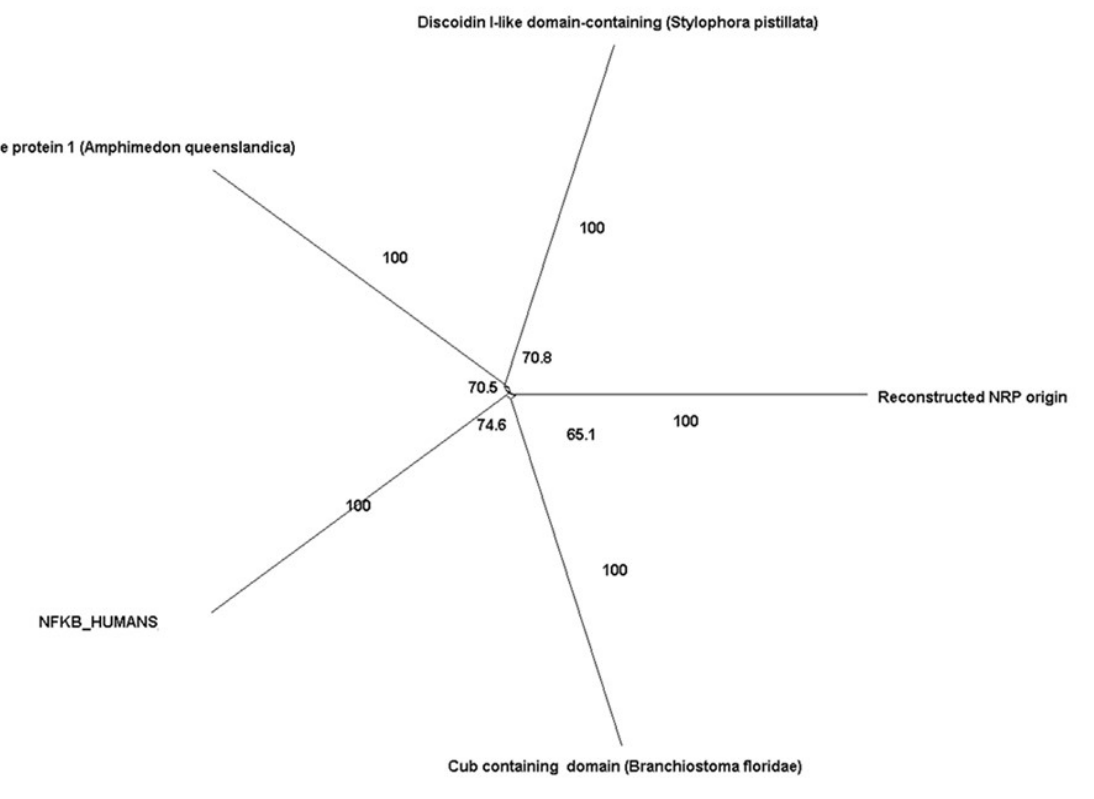
Figure 5. Evolutionary network of Neuropilin family. SplitTrees analysis results suggest that the origin of neuropilin could be more related to Discoidin I-like domains and cub-containing domains than Tollid domains.